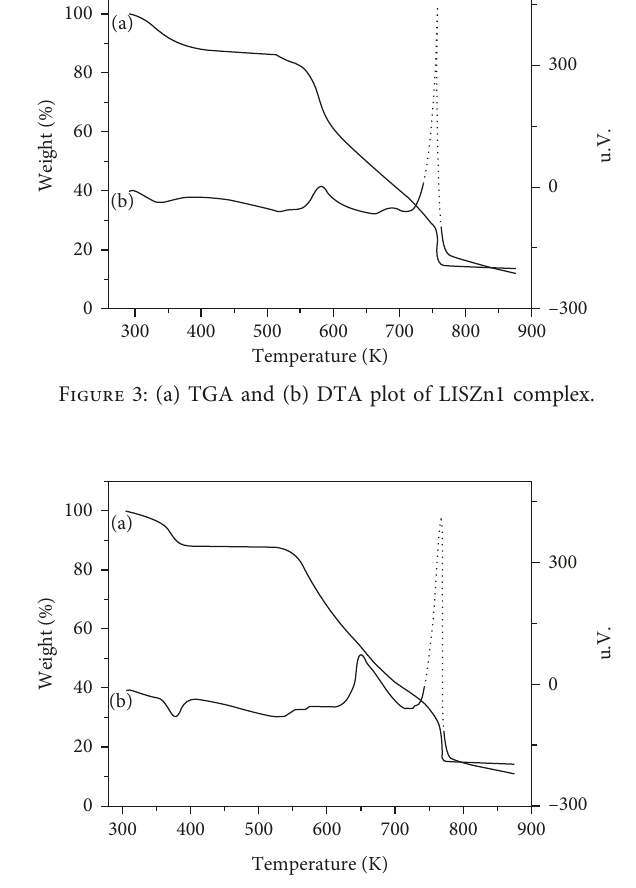
Figure 4: (a) TGA and (b) DTA plot of LISZn2